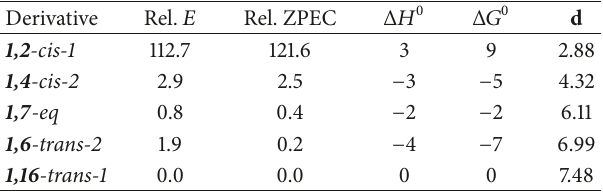
Table 1: The relative energies (rel. 𝐸 ), relative ZPEC energies (rel. ZPEC), relative enthalpy (rel. Δ𝐻 0 ), and relative Gibbs free energies (rel. Δ𝐺 0 ) in units of meV and distance ( d , ˚A) between the two methyls of the five C 20 H 18 (CH 3 ) 2 derivatives using B3LYP/6-31G(d, p) calculations a